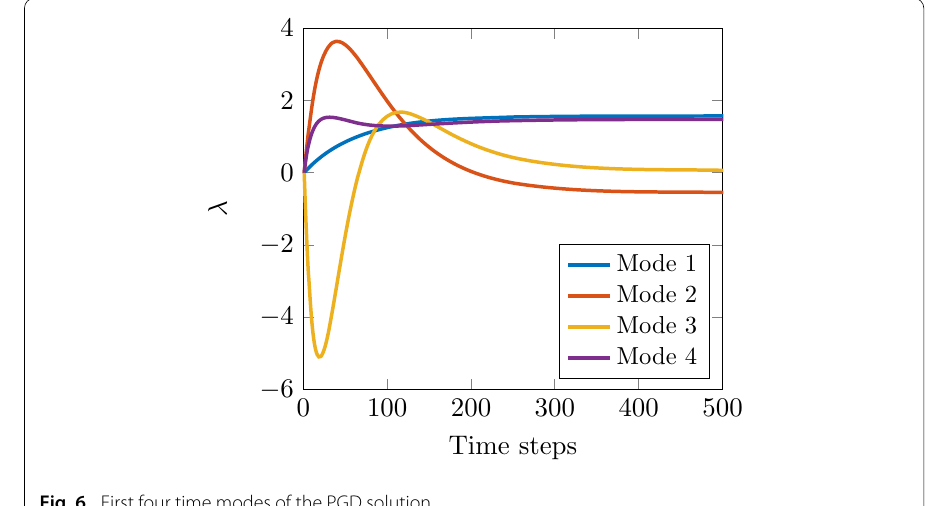
Fig. 6 First four time modes of the PGD